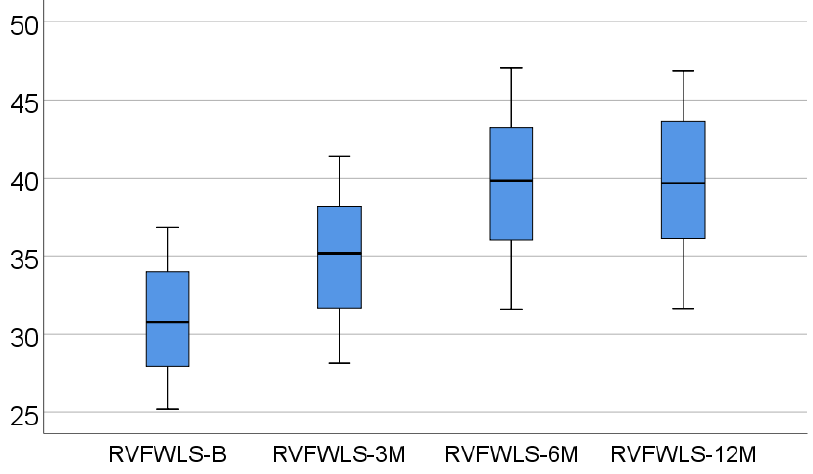
Figure 1. Box-plot representation of RVFWLS evolution.